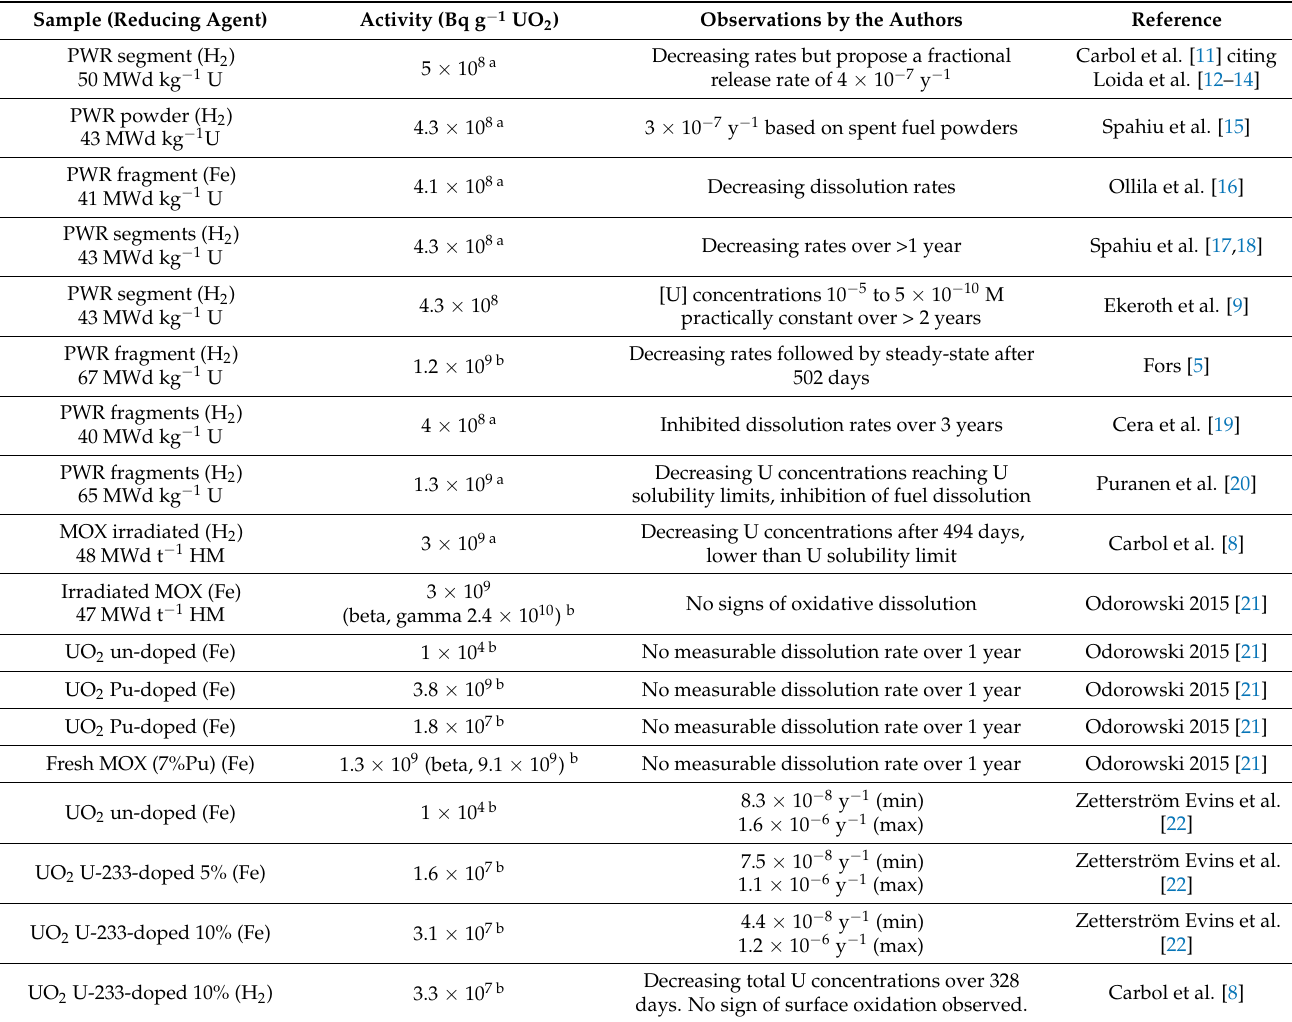
Table 1. Summary of release rates in reducing